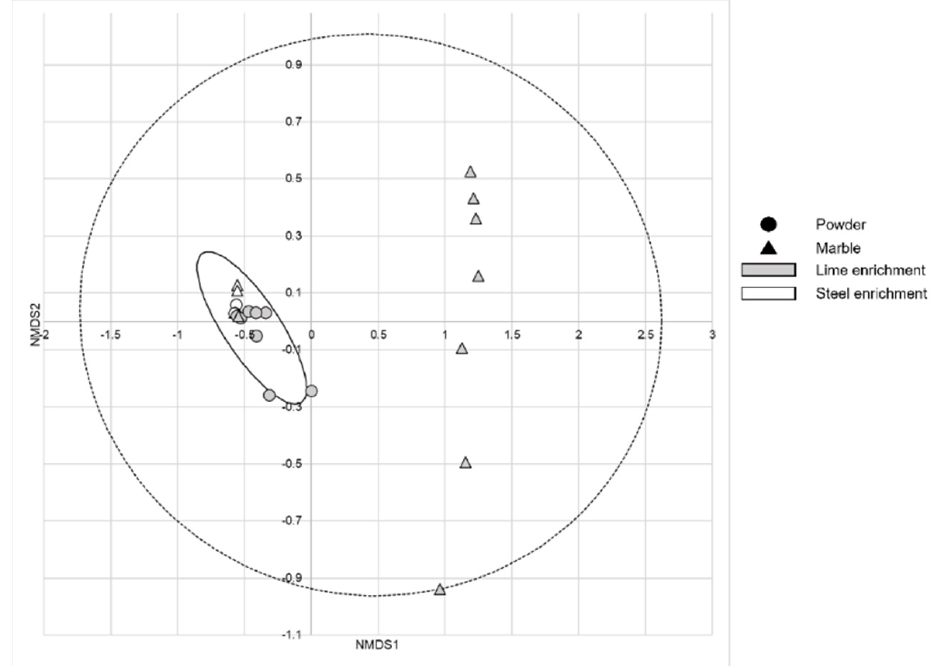
Figure 5. NMDS analysis illustrating the similarities between the steel site sediment enrichments supplemented with either calcium carbonate powder or marble chips and the lime site sediment enrichments supplemented with calcium carbonate powder. There was more dissimilarity between these sediments and the lime site sediment enrichments supplemented with the marble chips. Ellipses include all the sites within the NMDS based upon supplement (inner ellipse = powder) centred on the mean NMDS for those